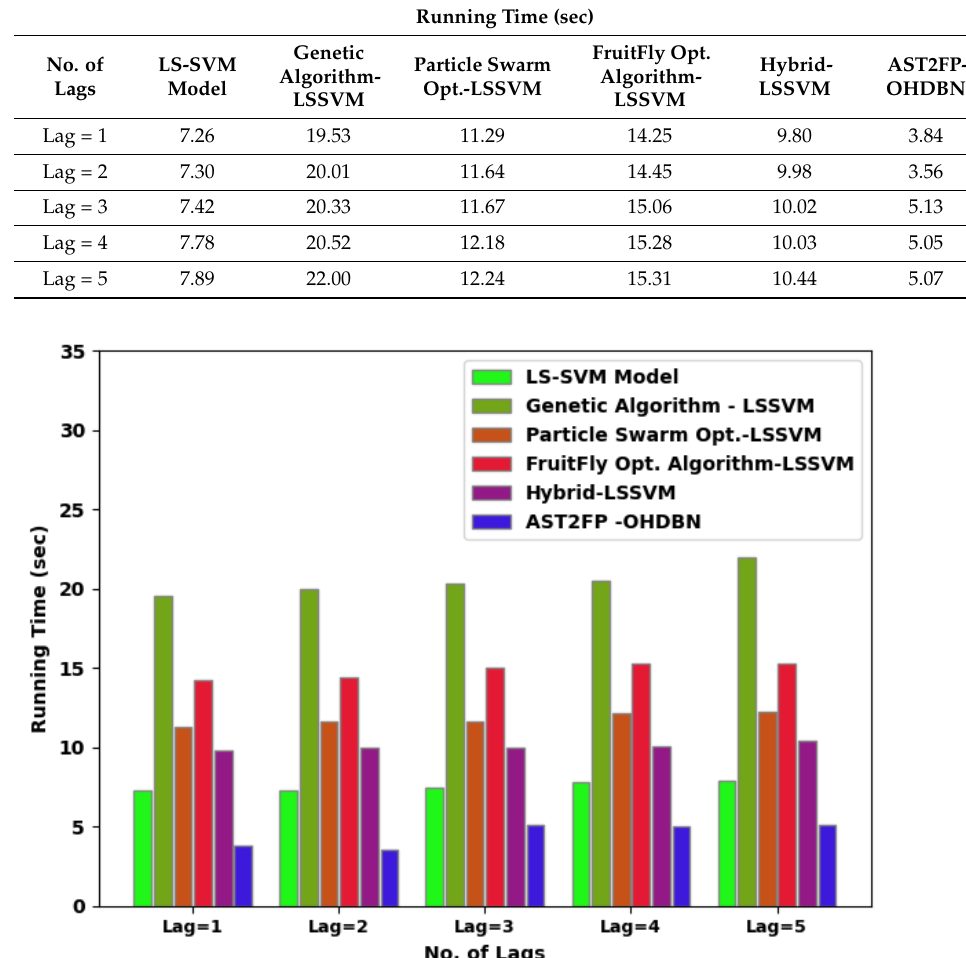
Figure 8. RT analysis of AST2FP-OHDBN approach with existing